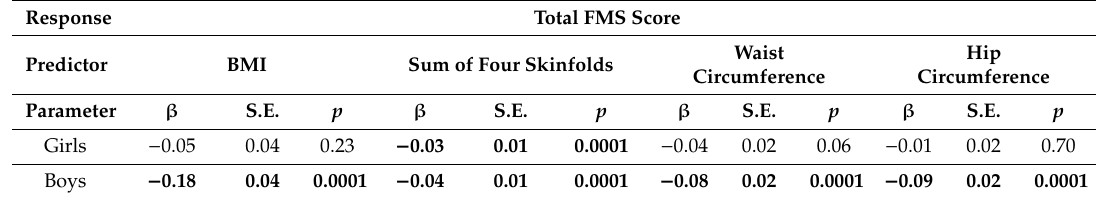
Table 3. Relationship between variables of adiposity and total FMS score among girls and